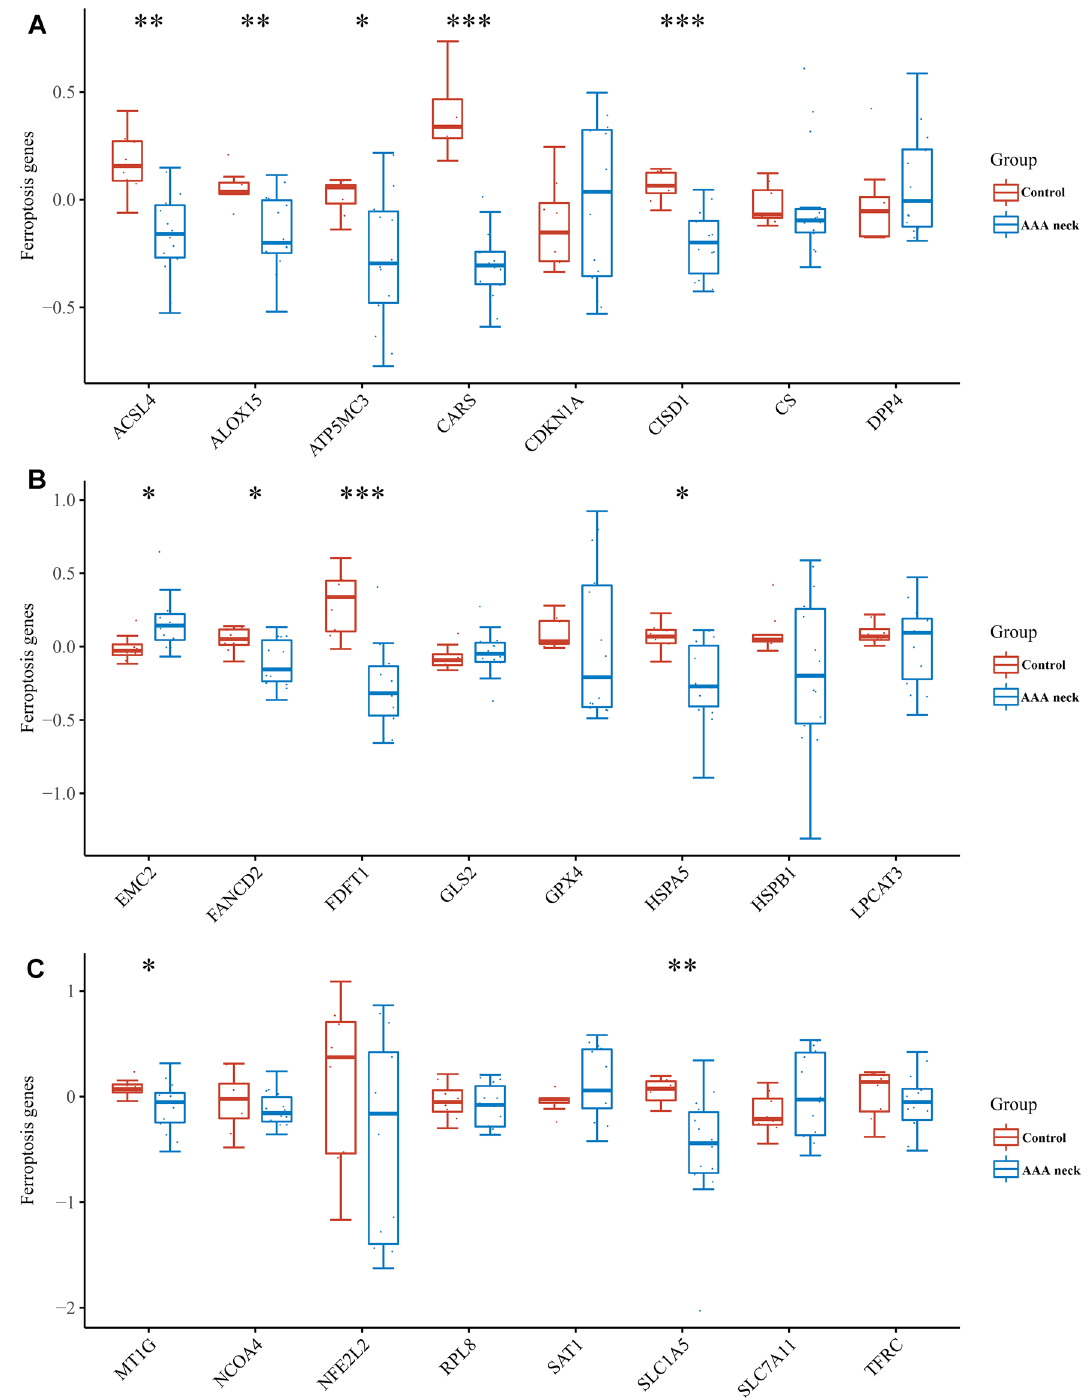
Figure 6. The expression of 24 ferroptosis related genes in the neck of AAA and normal tissues. ( A–C ) The box plots showing the expression of ferroptosis related genes in human AAA neck (n = 14) and donor tissues (n = 8) in GSE47472 dataset. Wilcoxon test was used to compare the differential expression of ferroptosis related genes. * p < 0.05, ** p < 0.01, *** p < 0.001 AAA neck vs. control